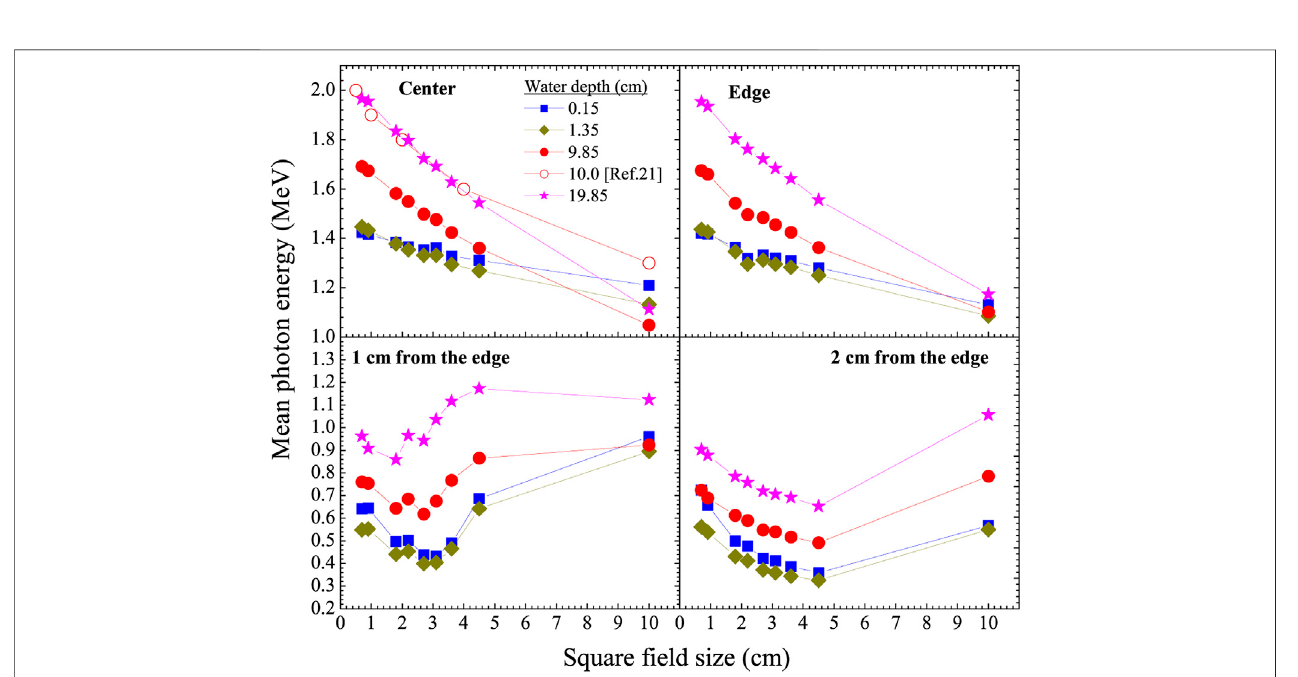
FIGURE 3 | Mean photon energy as a function of square FS for four water depths and several OADs.